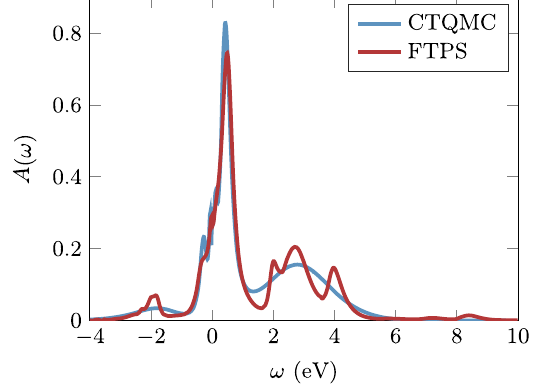
FIG. 5. DMFT spectral functions A ð ω Þ from CTQMC þ MaxEnt (blue line) at β ¼ 200 eV − 1 , and from FTPS (red line). The FTPS result shows a distinctive three-peak structure in the upper Hubbard band.